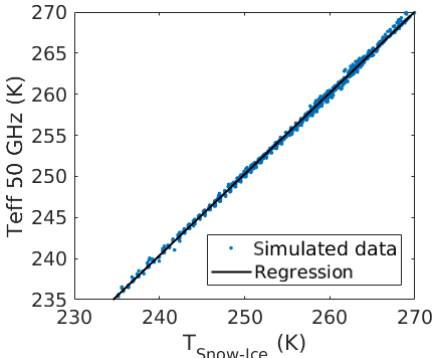
Figure 11. Regression of the T eff as a function of T Snow − Ice at 50GHz in vertical polarization. The data from the MEMLS simu- lations are in blue points and the linear regression is the solid black